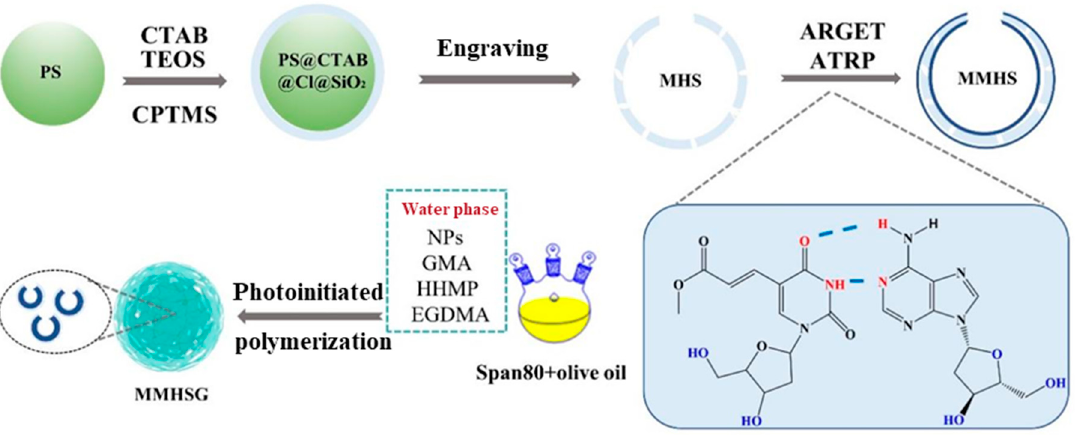
Figure 1. Synthesis mechanism of composite hydrogel adsorbent encapsulating imprinted hollow mesoporous nanoparticles (MMHSGs).